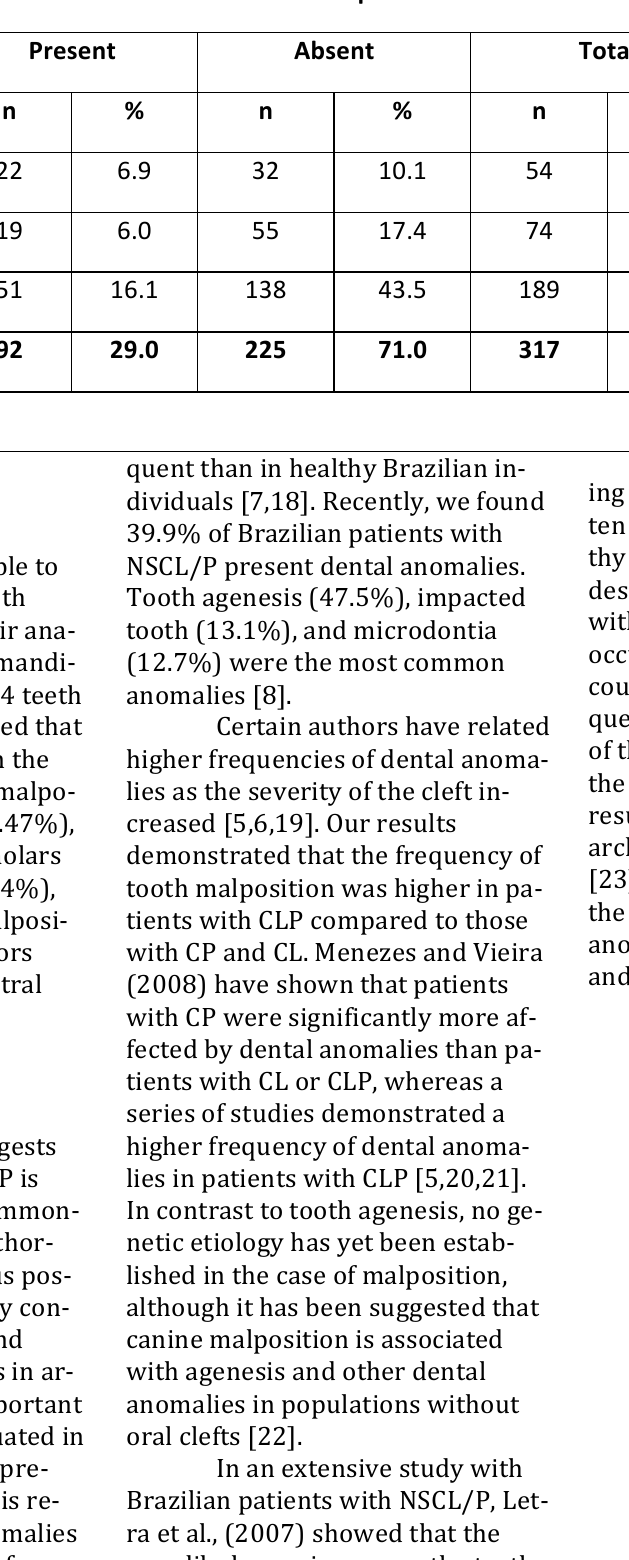
Table 2. Frequency of patients with tooth malposition according to the types of oral clefts. Type of